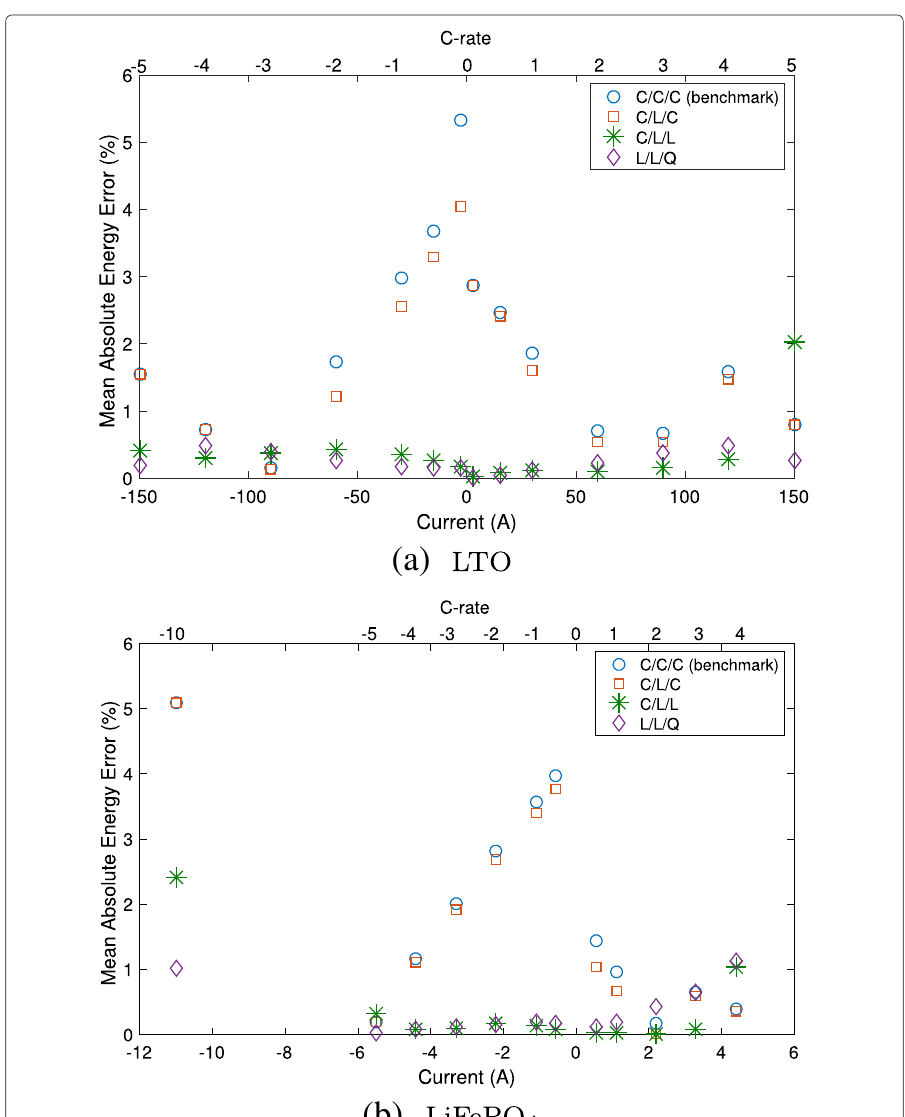
Fig. 5 Mean absolute energy error for LTO cell ( a ) and LiFePO4 cell ( b ) for constant-current cycles at different C-rates (top scale)/Amperes (bottom scale)